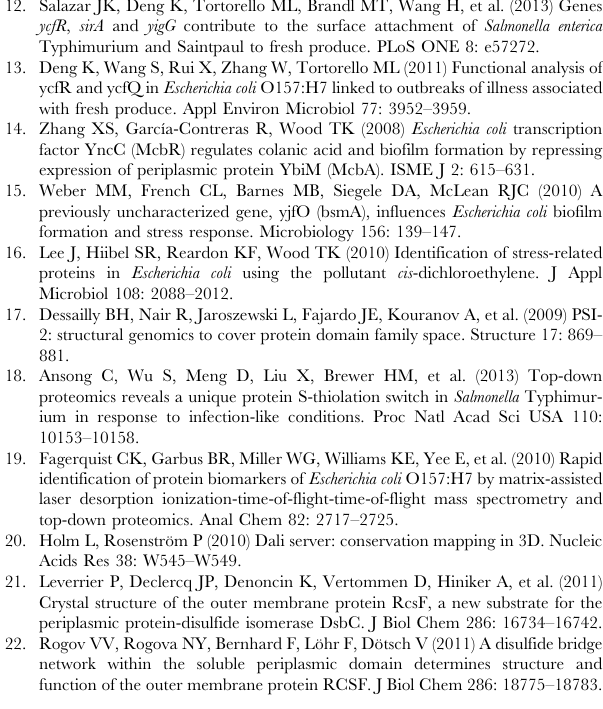
Figure S1 Comparison of solution-state SrfN dimer with crystallographic dimer for SssB-III. Ribbon cartoon depictions of SrfN dimer (left) and SssB crystallographic dimer (right). Figure S2 Strictly conserved residues in the SrfN subfamily. Residues conserved in all sequences shown in Fig. 1, panel C are mapped onto the structure as light blue spheres. Figure S3 Homology models of other DUF1471 proteins from Salmonella and YbiM from E. coli . The models indicate the diversity of surface electrostatic characteristics across the family. The surfaces were calculated and are displayed in the same way described in the Fig. 2 caption.